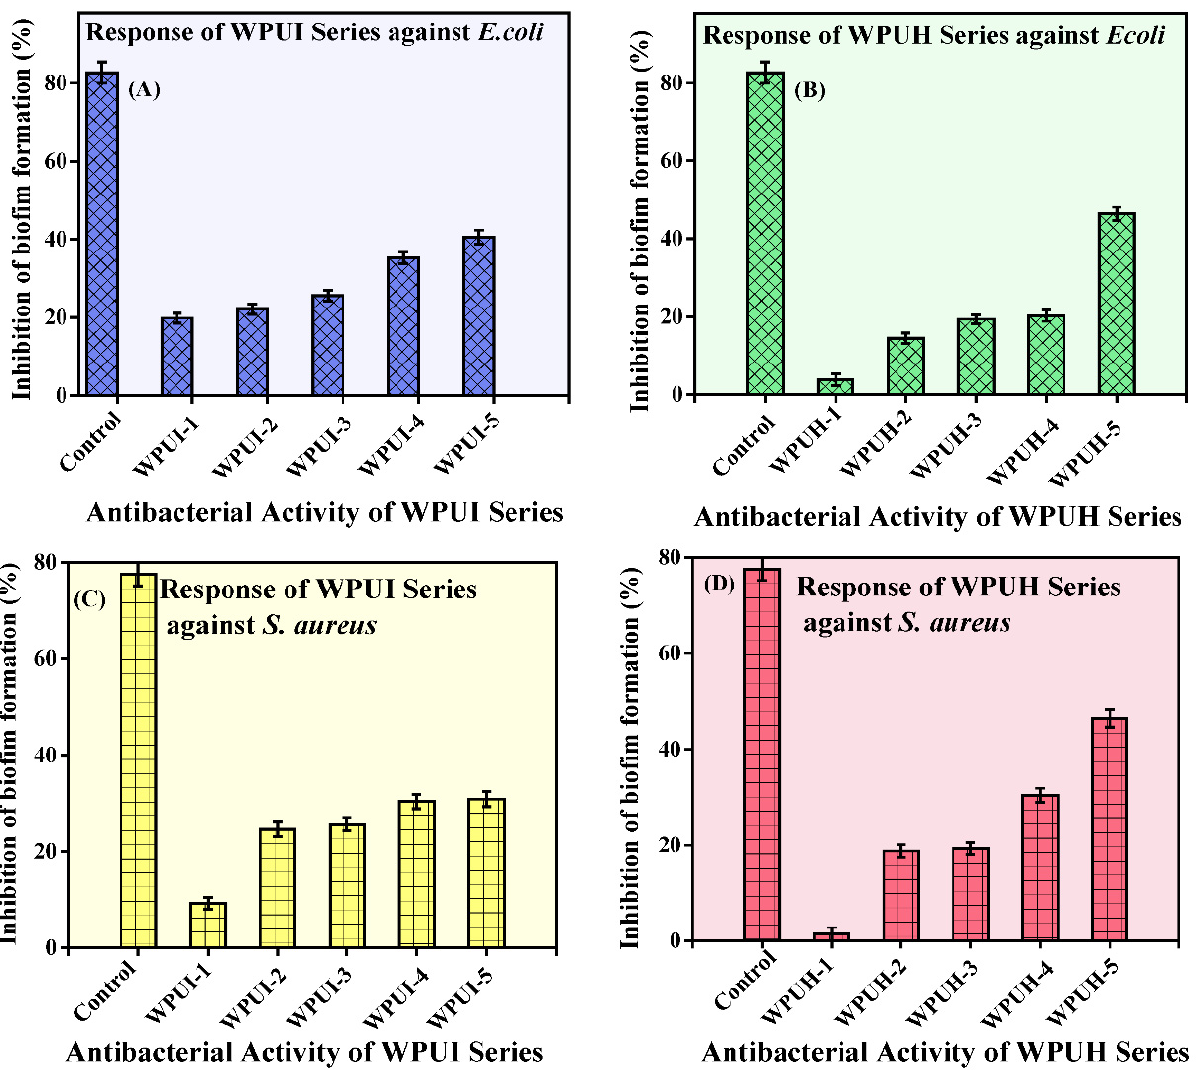
Figure 6. Biofilm inhibitory activity of the WPUDs. ( A ) WPUI series against E. coli . ( B ) WPUH series against E. coli . ( C ) WPUI series against S. aureus . ( D ) WPUH series against S. aureus .